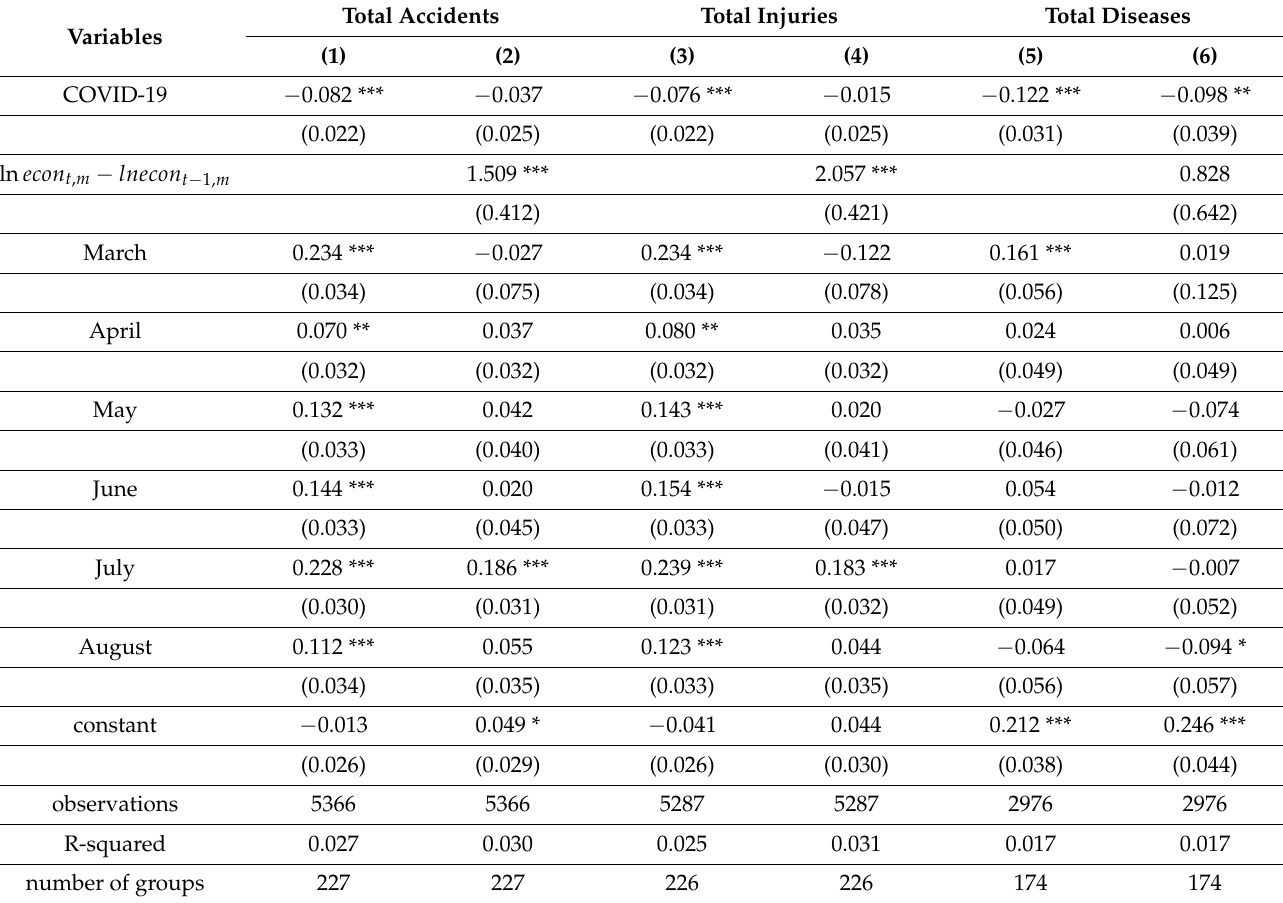
Table 3. Estimation results of fixed effects models without year